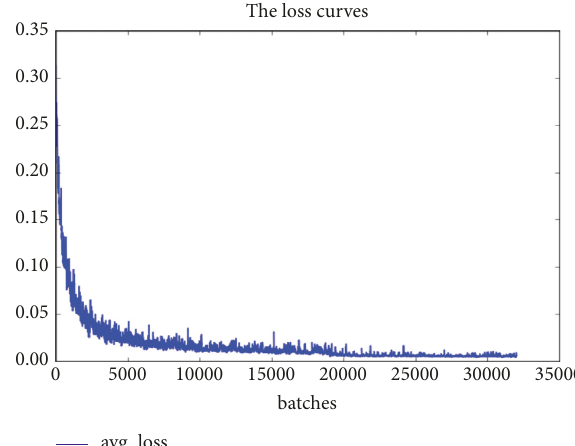
Figure 10: Loss function curve.